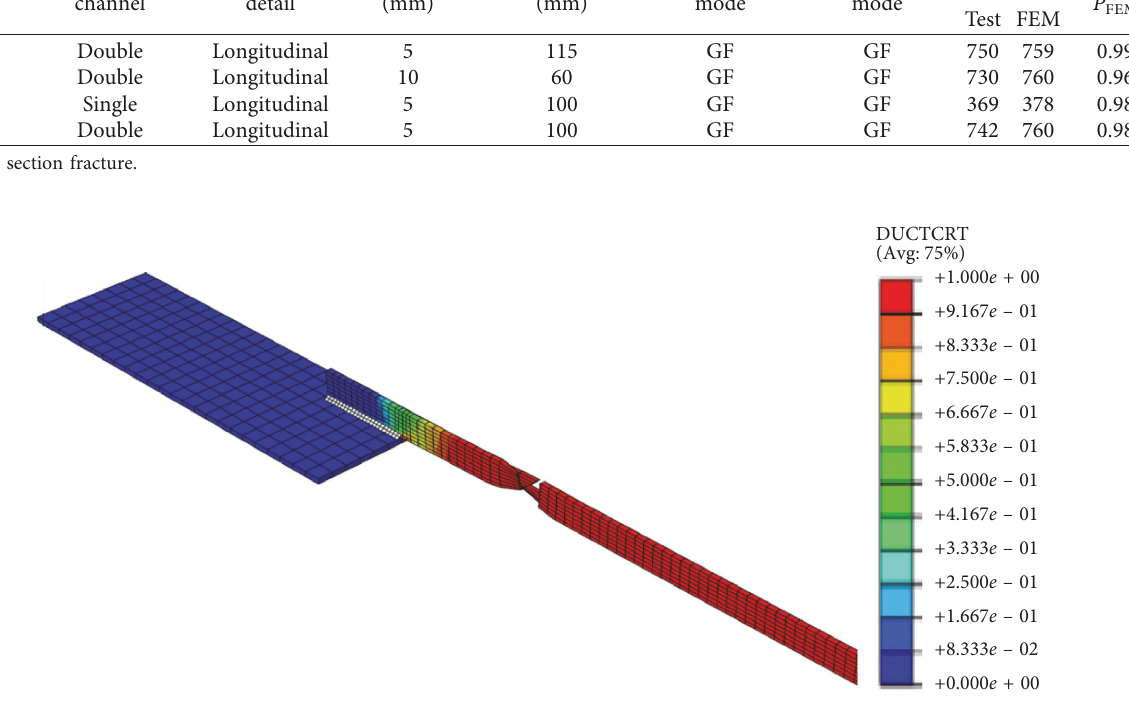
Figure 6: Fracture of specimen 1 in the FE model.